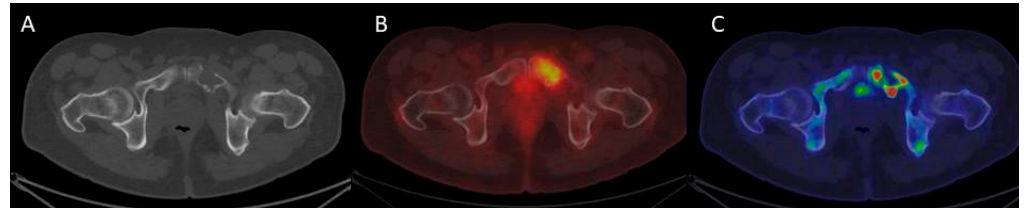
Figure 4. ( A ) CT of the pelvis showed a lytic lesion of the left pubic area. ( B ) 18 F-FDG PET/CT demonstrated increased metabolism localized within the osteolytic lesion consistent with myeloma cells. ( C ) PET/CT with 18 F-Sodium Fluoride (NaF) revealed increased patchy uptake in the periphery of the lytic lesion indicating areas bone remodeling activity.